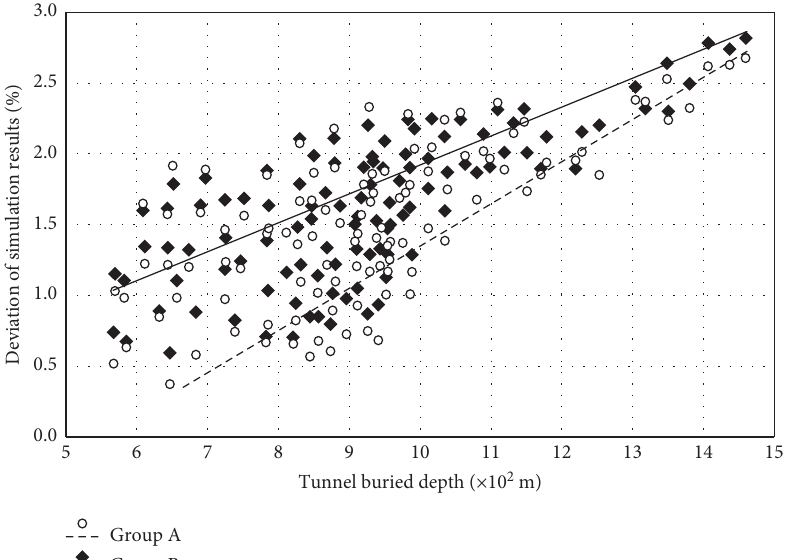
Figure 5: Linear regression relationship between simulation results and measured results (based on tunnel buried depth) (data source: collected by the study).